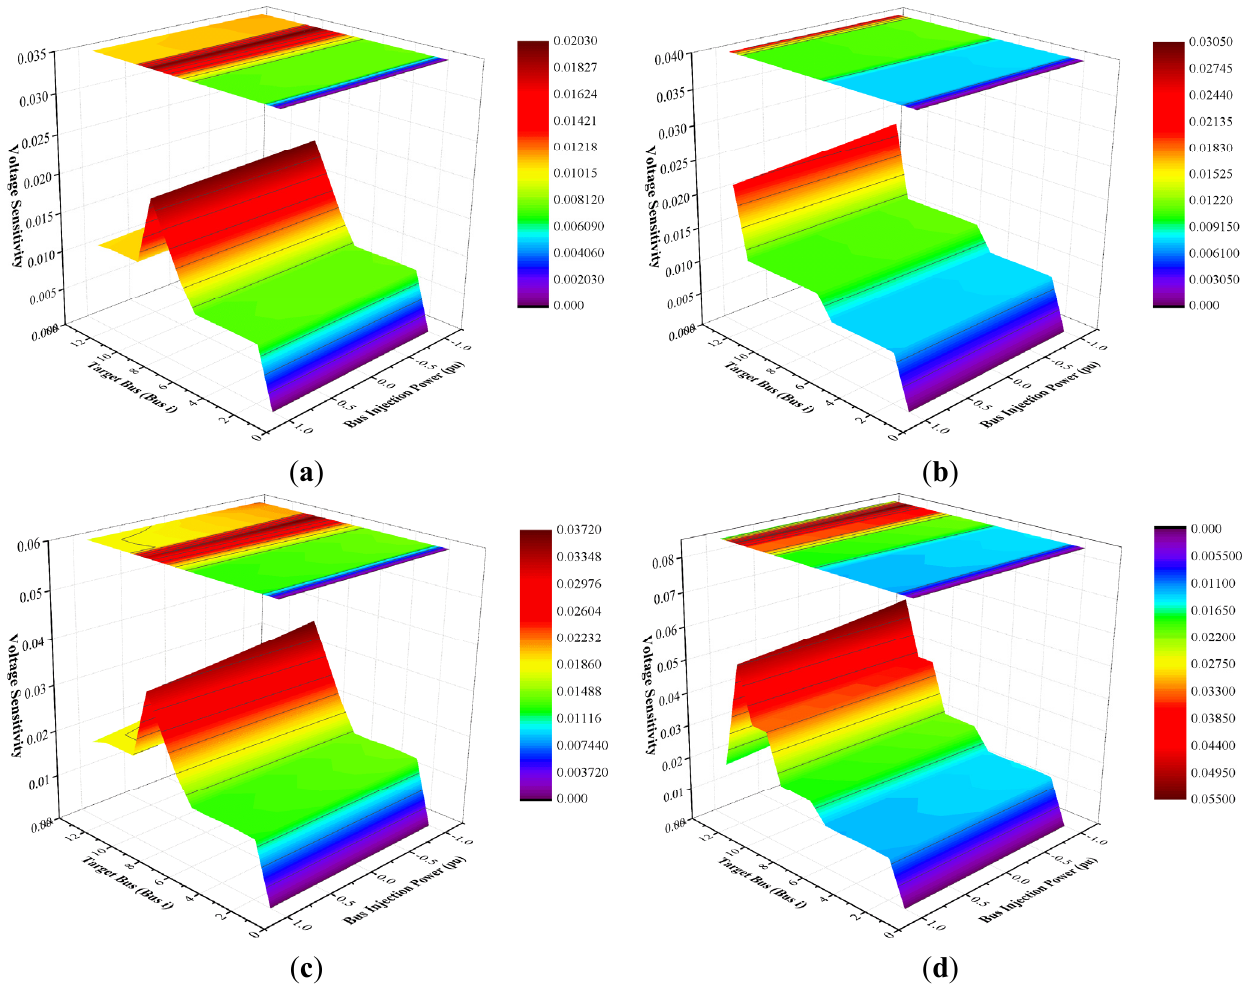
Figure 9. The results of the exact calculation of the voltage sensitivity in response to changes in the bus injected power. ( a ) j is bus 9 and V slack = 1.0 pu; ( b ) j is bus 12 and V slack = 1.0 pu; ( c ) j is bus 9 and V slack = 0.6 pu; ( d ) j is bus 12 and V slack = 0.6